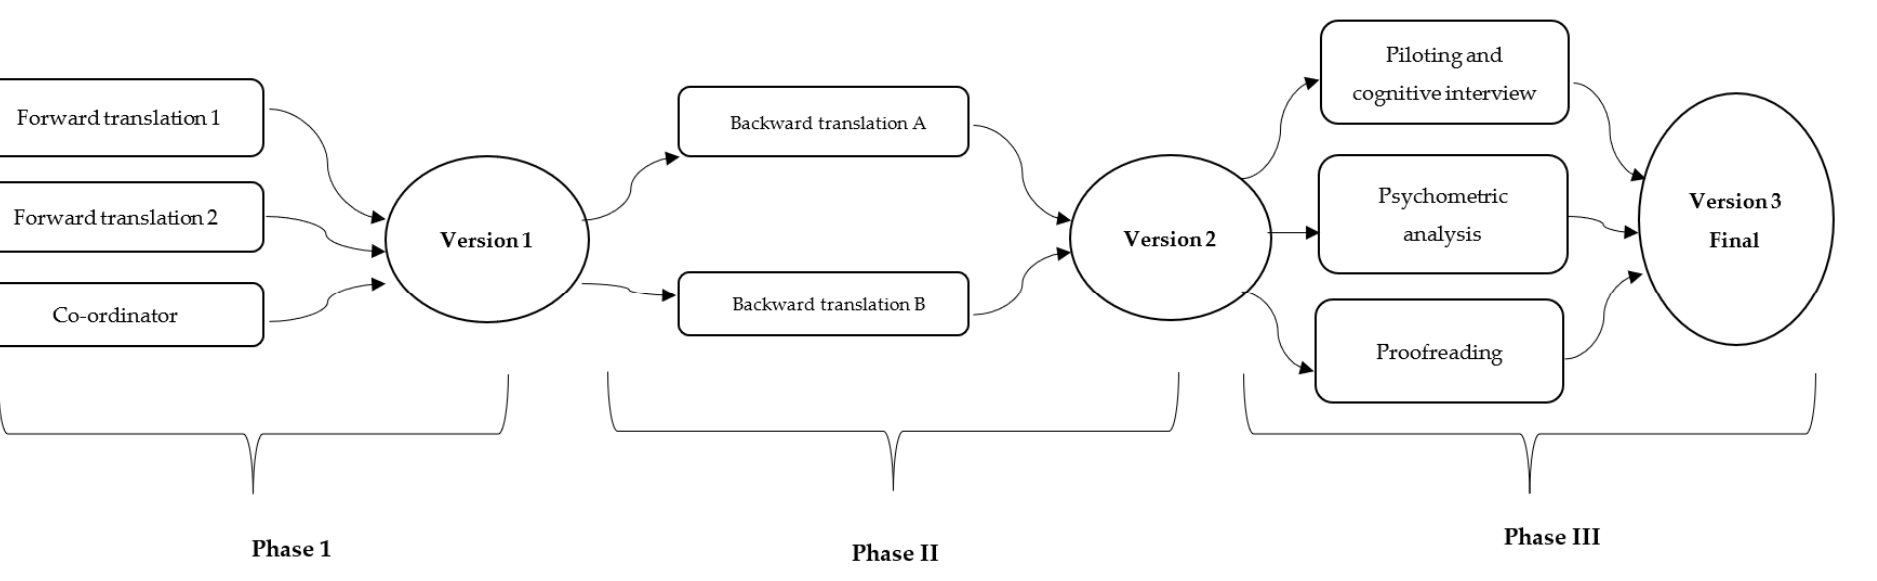
Figure 1. The translation and validation process of FiRST.